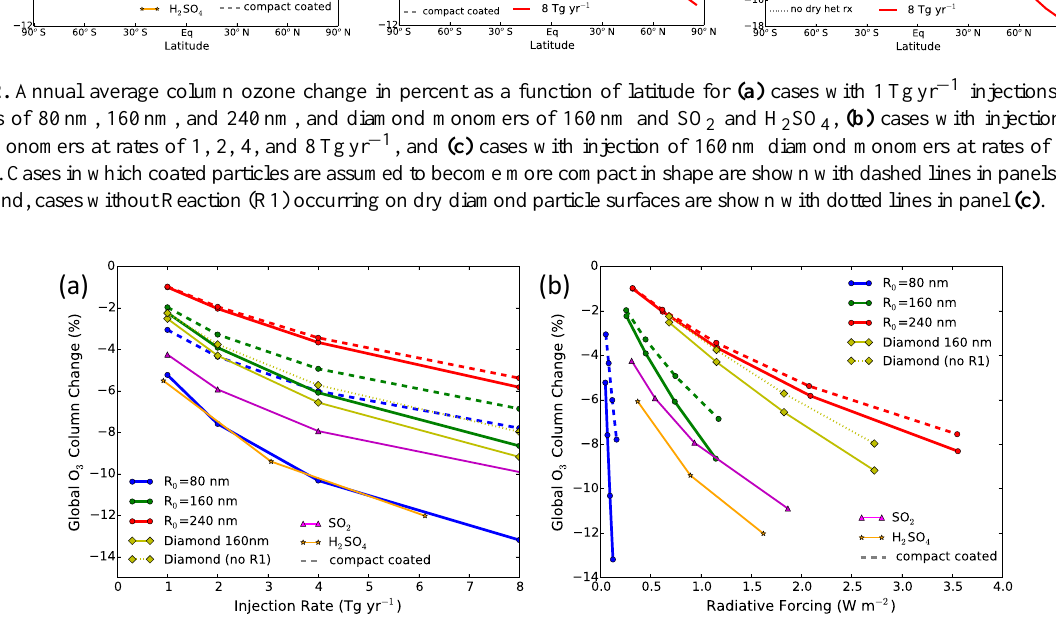
Figure 13. Global annual average column ozone change (in percent) (a) as a function of injection rate and (b) as a function of associated shortwave radiative forcing. Ozone change for diamond is shown with and without Reaction (R1) on uncoated diamond particles. Calculations with SO 2 and H 2 SO 4 injections employ the same model to calculate radiative forcing and ozone depletion as for alumina and